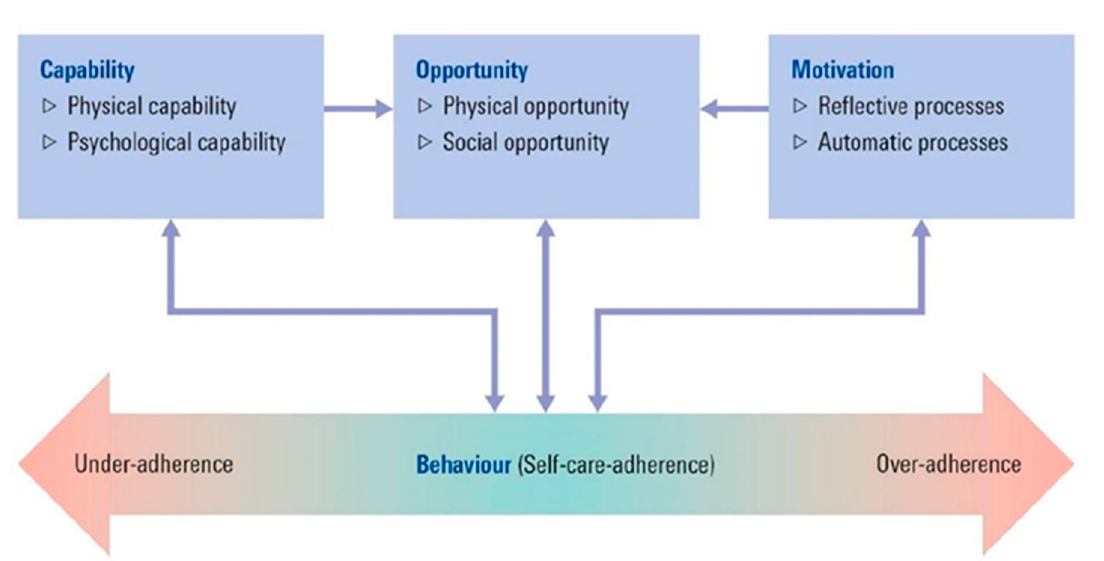
Figure 2. The capability, opportunity and motivation behaviour (COM-B) model and its compo- nents [69].